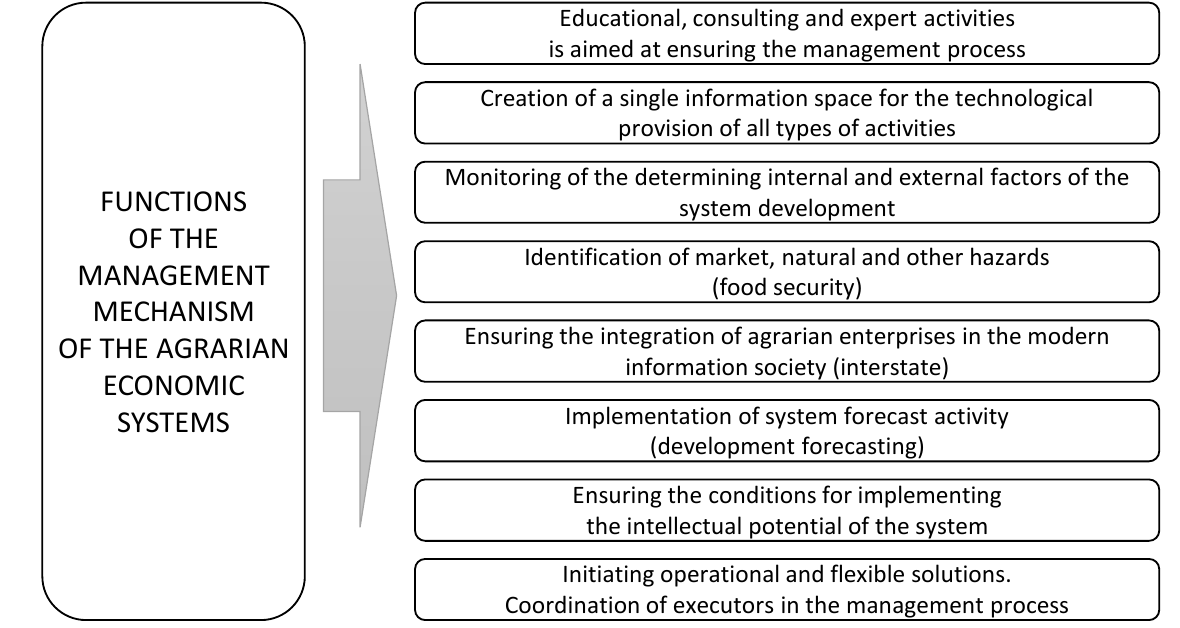
Figure 5. Functions of the management mechanism of the agrarian economic systems